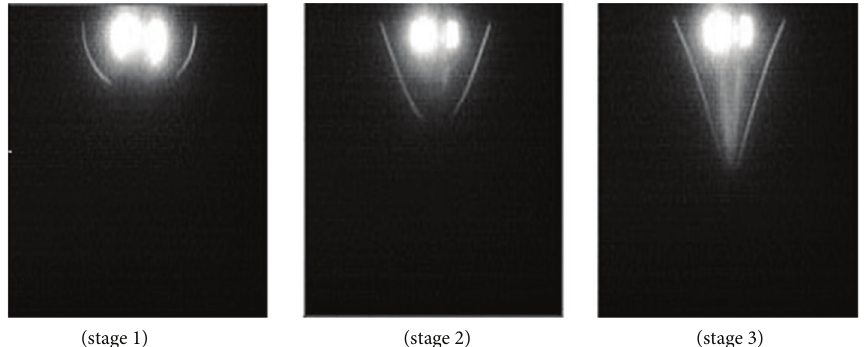
Figure 12: Formation of the Taylor cone [89].